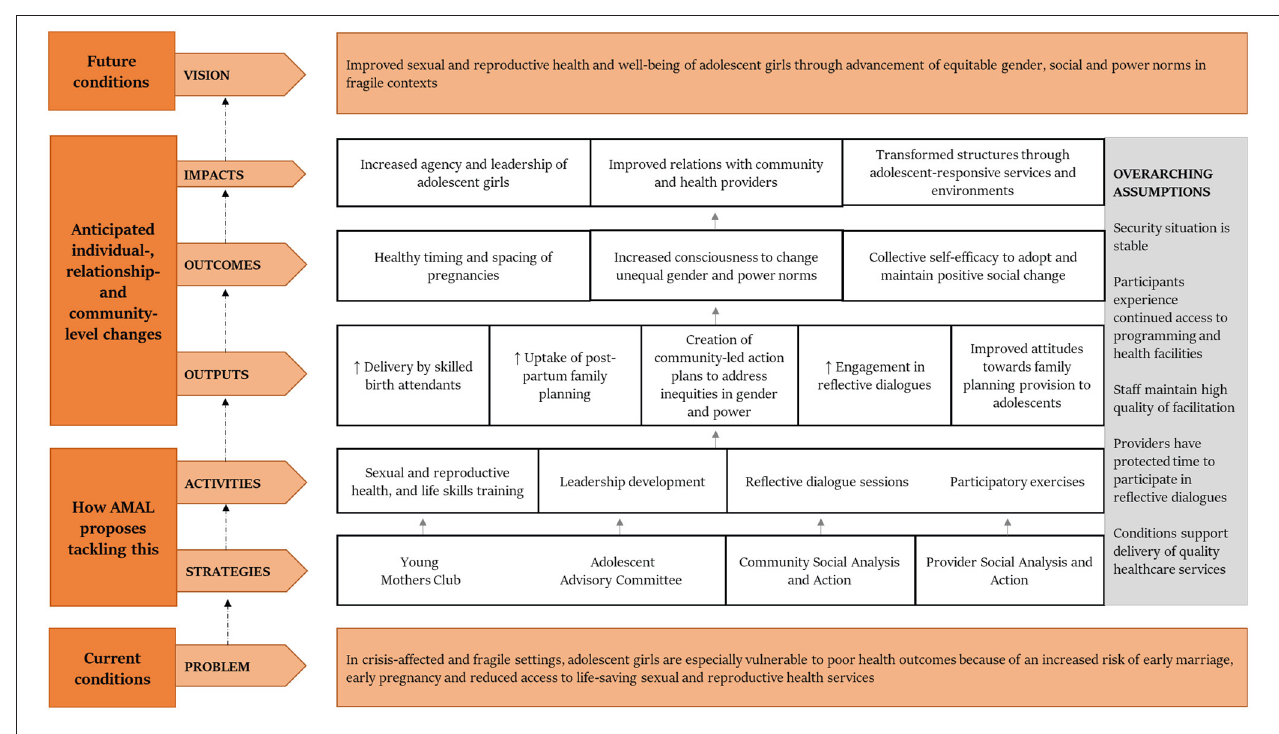
FIGURE 1 | The AMAL initiative’s theory of